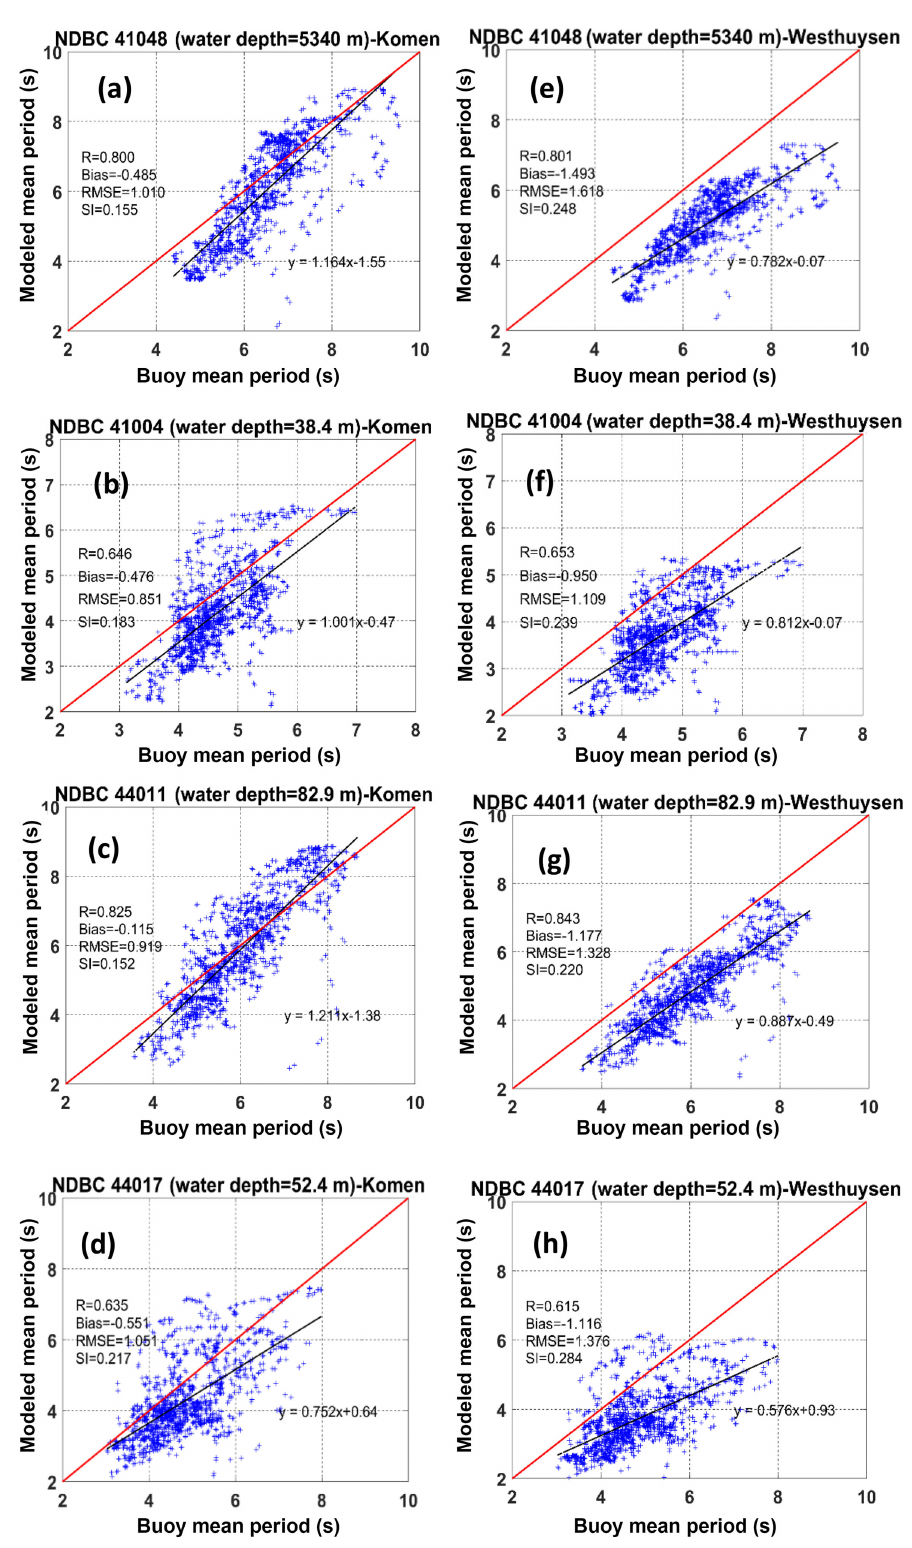
Figure 8. Scatter plots and model performance metrics for simulated mean wave period using (a–d) Komen whitecapping and (e–h) West- huysen whitecapping at the NDBC buoys. The red and black lines are the 1 : 1 line and regression line,